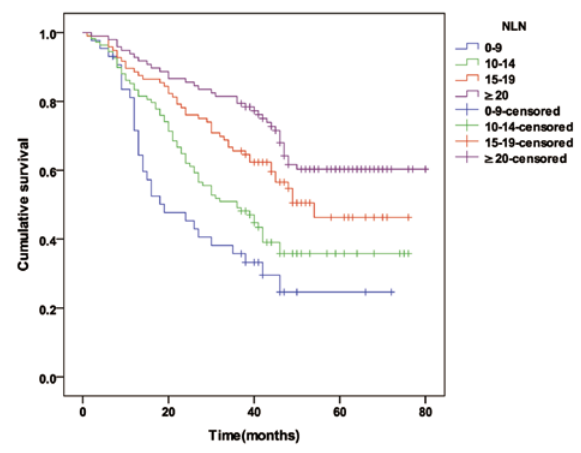
Figure 2: The overall survival curve for node-negative patients with 9 or less, 10 to 14, 15 to 19 and 20 or more